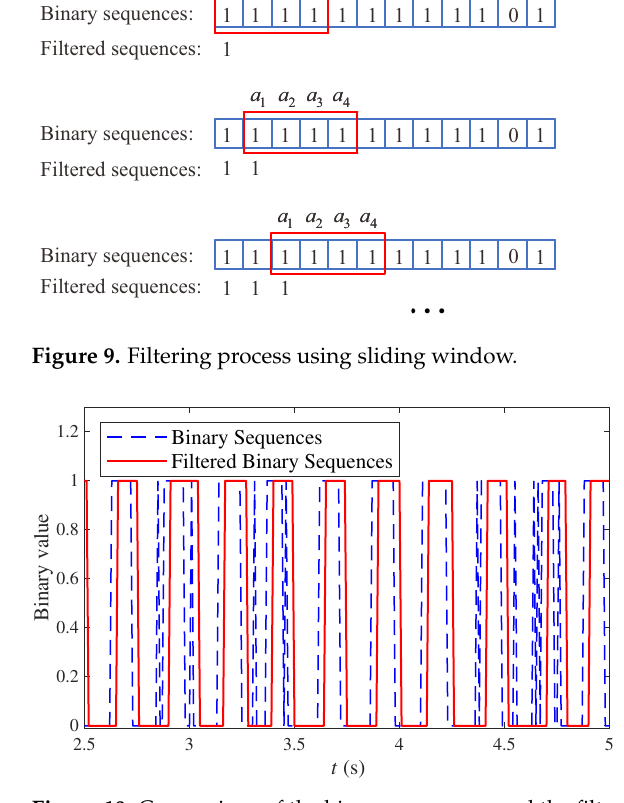
Figure 10. Comparison of the binary sequences and the filtered binary sequences within t ∈ [ 2.5,5.0 ]